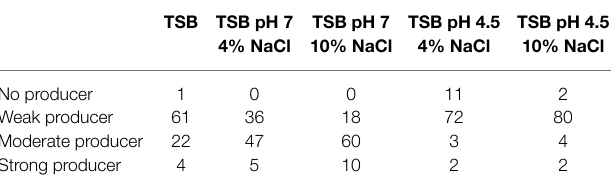
TABLE 1 | Frequency of Salmonella isolates ( n = 88) per categories: “no biofilm producer,” “weak producer,” “moderate producer,” and “strong producer” when tested in different